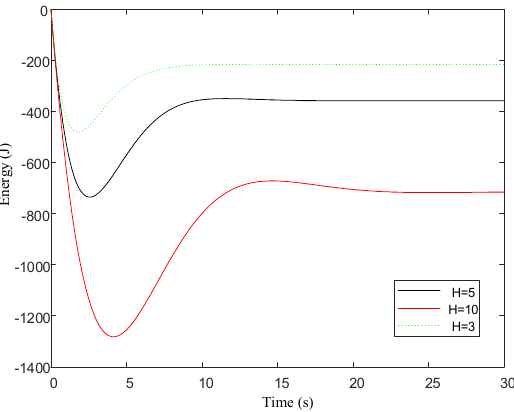
Figure 11. Energy provided by inertia property.